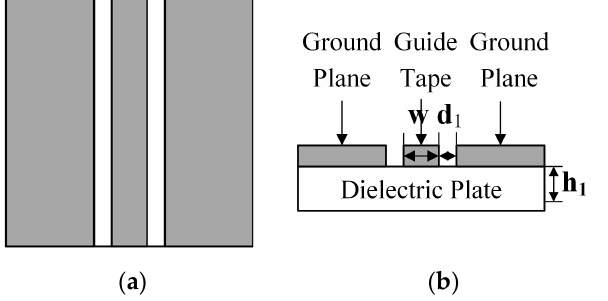
Figure 3. Schematic diagram of CPW feed line: ( a ) top view of CPW feed line; ( b ) section diagram of CPW feed line.